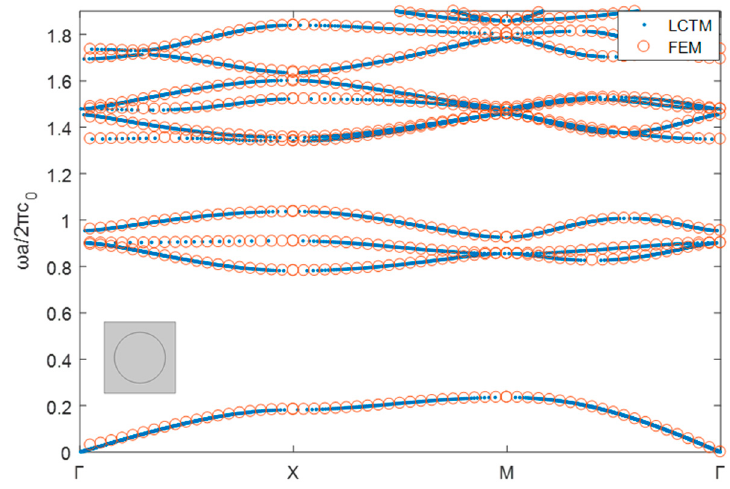
Figure 6. Band structure of the anti-plane transverse wave for aurum/epoxy phononic crystal calculated by the LCTM and the FEM (288 elements).